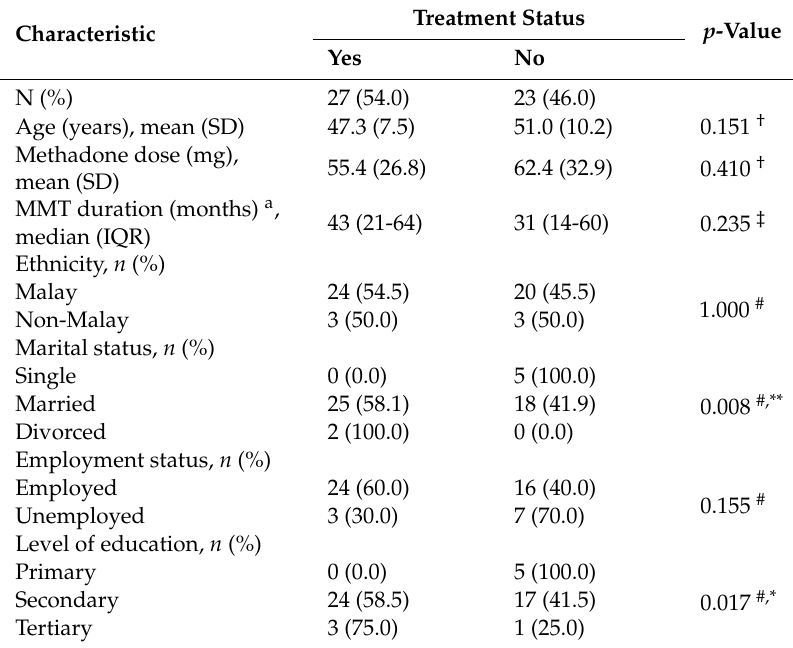
Table 2. Bivariate analysis of the associations between demographic and methadone treatment (dose and duration) factors and health-seeking behavior (treatment status) among MMT patients with ED ( n = 50).